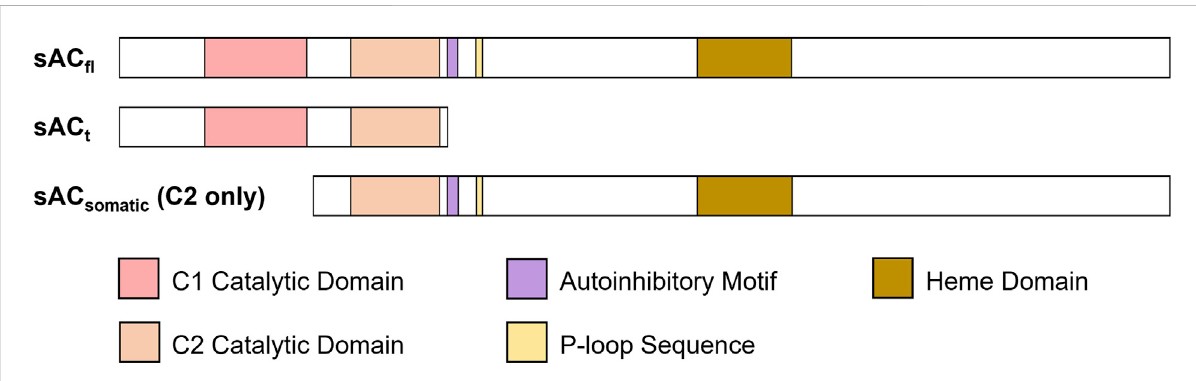
Different isoforms of sAC with catalytic and functional domains highlighted. sACt and sAC fl are present in testis and sperm, while sACsomatic appears to be ubiquitously